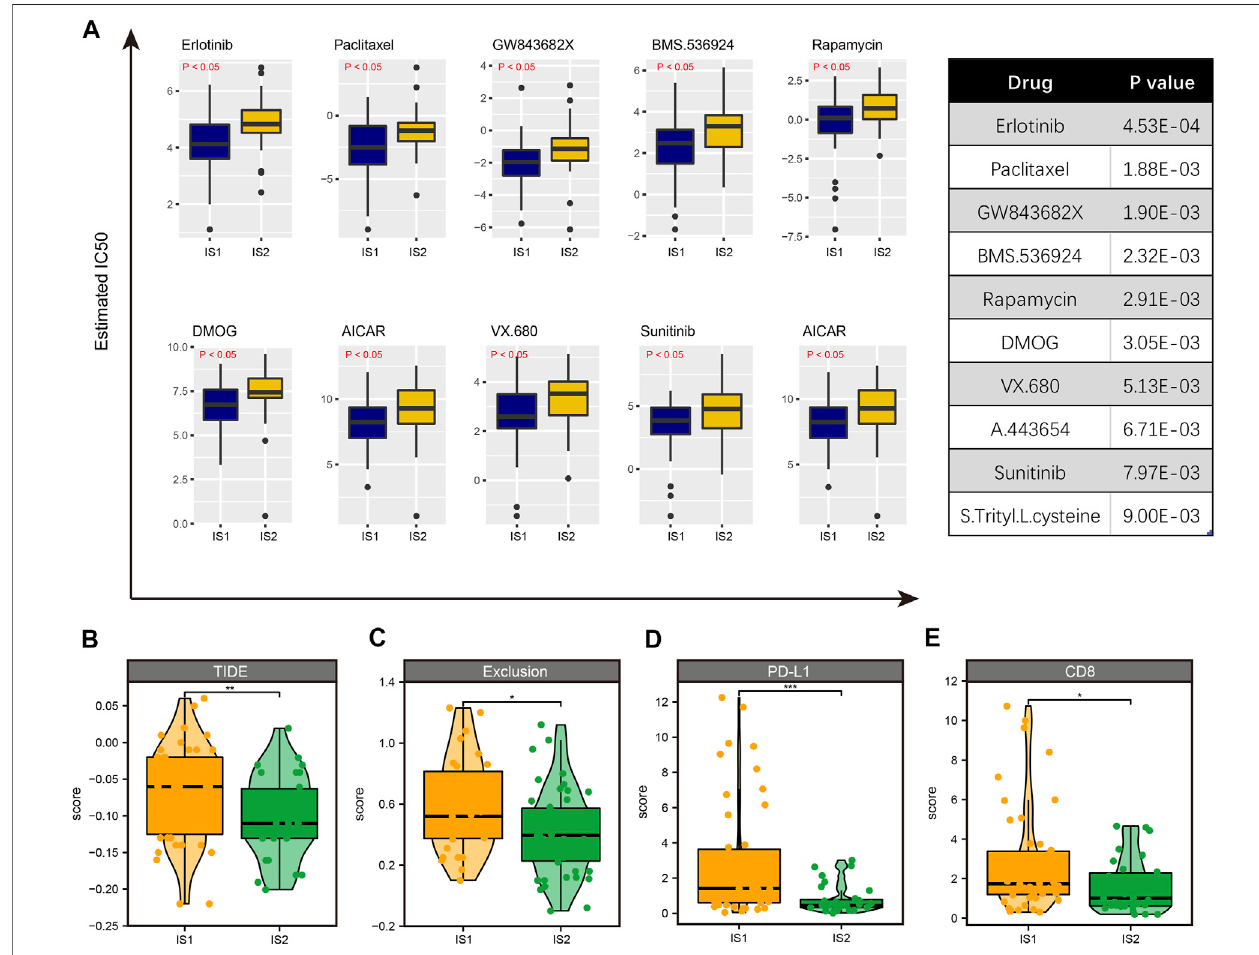
FIGURE9| Identi fi cation ofdrugsensitivity inIS1andIS2subtypes. (A) The10drugswiththemostsigni fi cantdifferencesrankedby p -value. (B) TheTIDEscoreis higherinIS1thaninIS2. (C) TheexclusivescoreishigherinIS1thaninIS2. (D) ThePD-L1scoreishigherinIS1thaninIS2. (E) TheCD8scoreishigherinIS1thaninIS2.